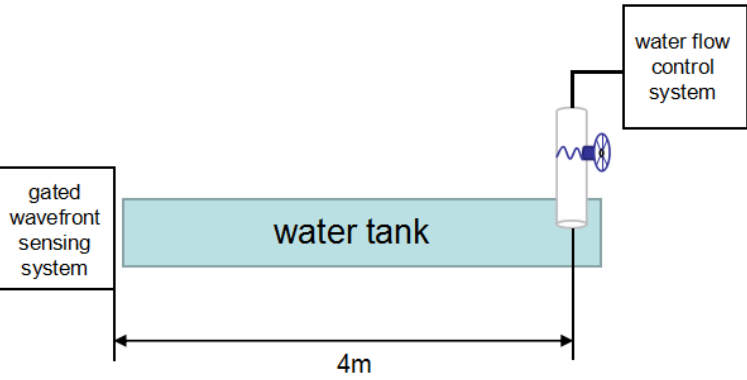
Figure 6. Gated wavefront sensing system and water tank control system.